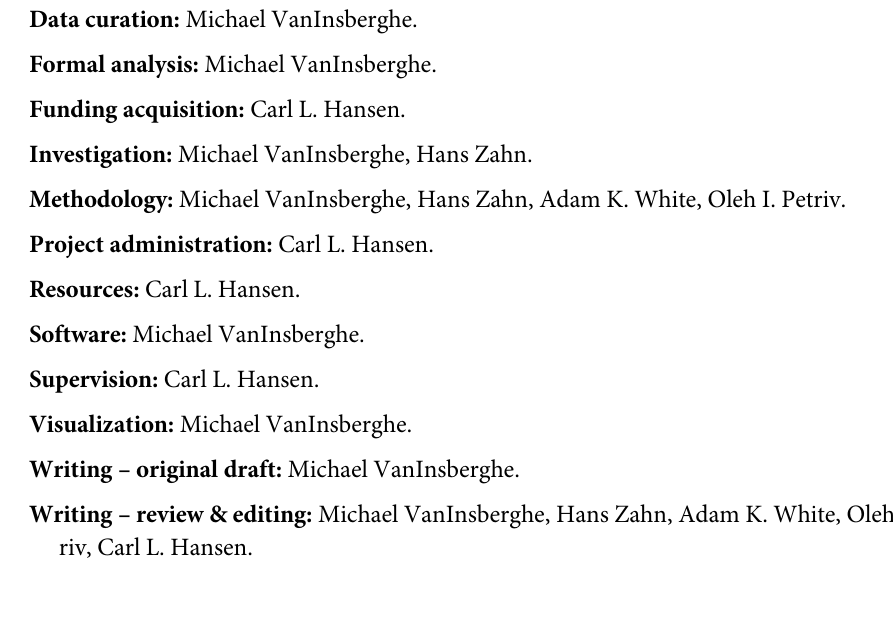
S2 Table. Single-cell gene expression method performance comparison. (PDF) S3 Table. Single-molecule dilution detection measurements. Expected number of molecules and 95% confidence intervals based on the digital array response curve for a 52-chamber array. Cell processing units were counted as positive if more than 15 of the 20 detection cham- bers (75%) had a CT value less than the cut-off. S4 Table. miRNA co-expression significance. Spearman correlation coefficients, raw, and Benjamini-Hochberg corrected p-values for each pairwise comparison for the K562 and BaF3 cells. Pairs in which either cell population did not express both miRNAs are denoted with NA.